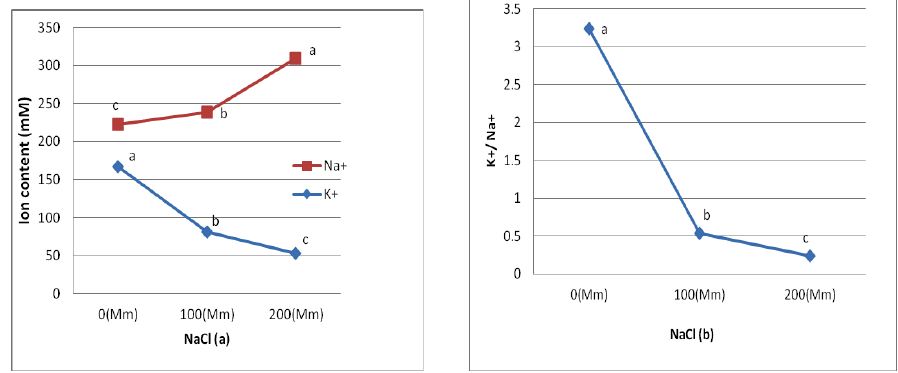
Fig. 2: Effect of in vitro NaCl stress on the K + and Na + content (a) and K + /Na + ratio of Plantago ovata callus. Mean with one or more letter in common are not significantly different at the 5% probability level as tested by LSD5 %